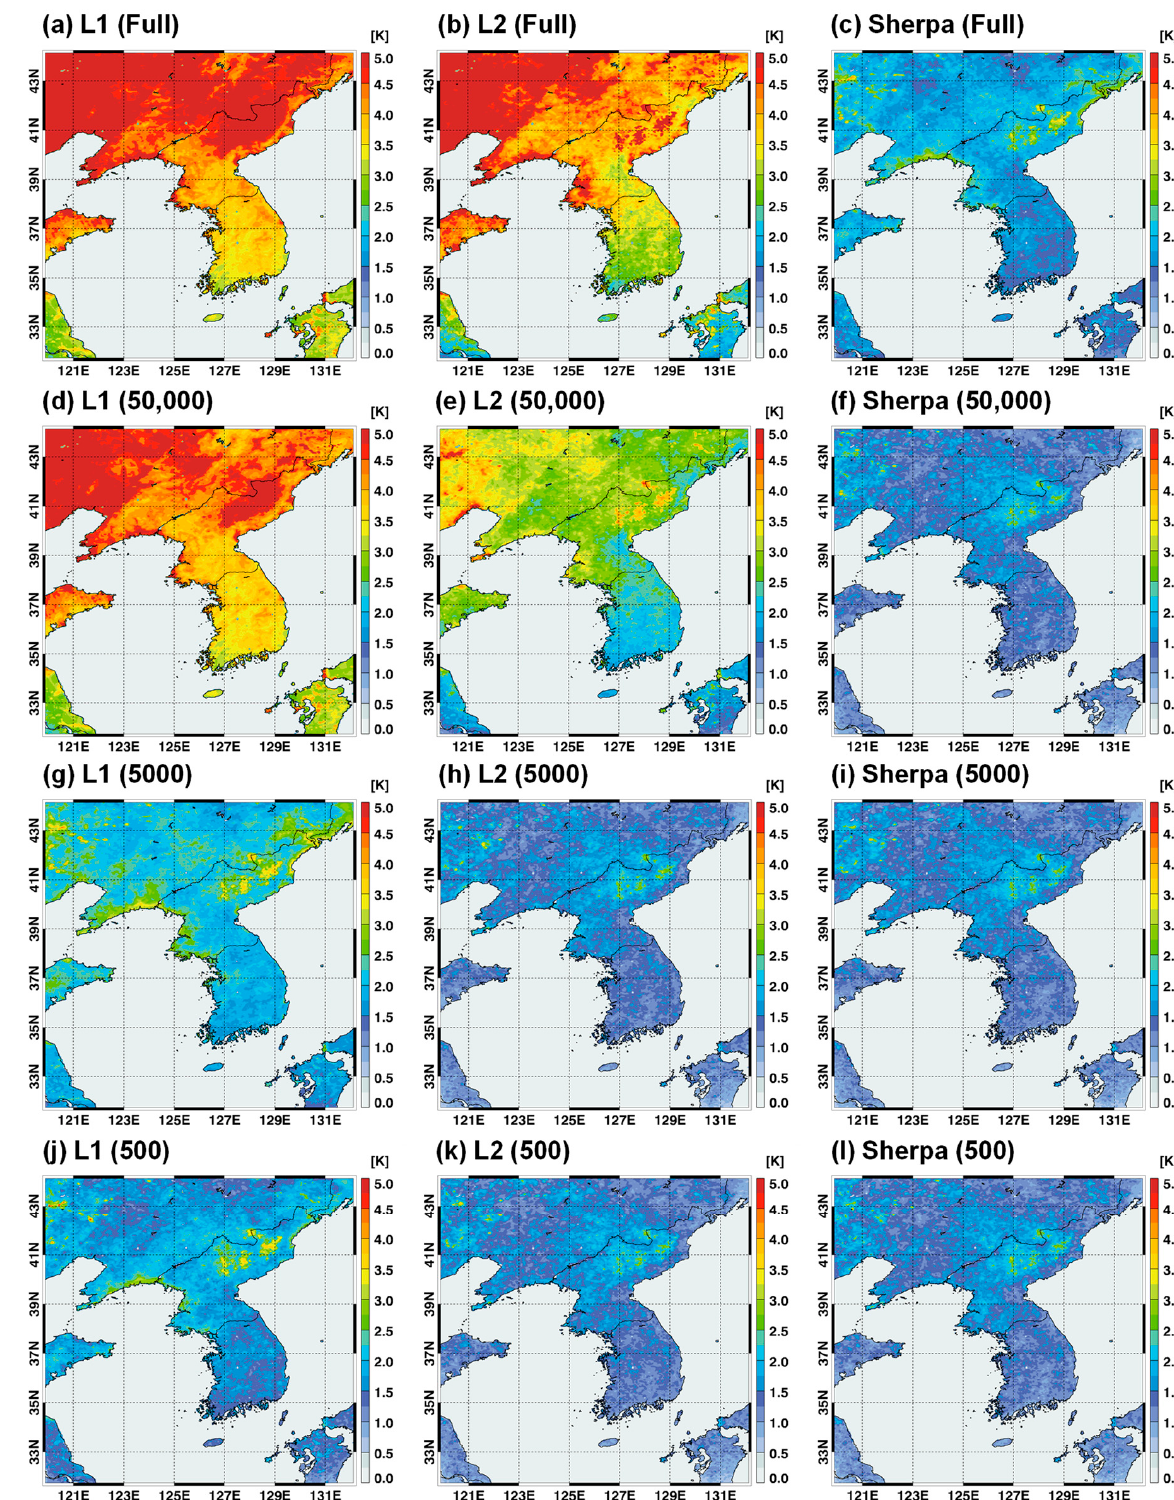
Figure 7. Spatial distributions of the root mean square errors (RMSEs) for skin temperature simulated from radiation emulators based on different batch sizes (( a – c ): Full, ( d – f ): 50,000, ( g – i ): 5000, ( j – l ): 500) and learning rates (L1, L2, and Sherpa).